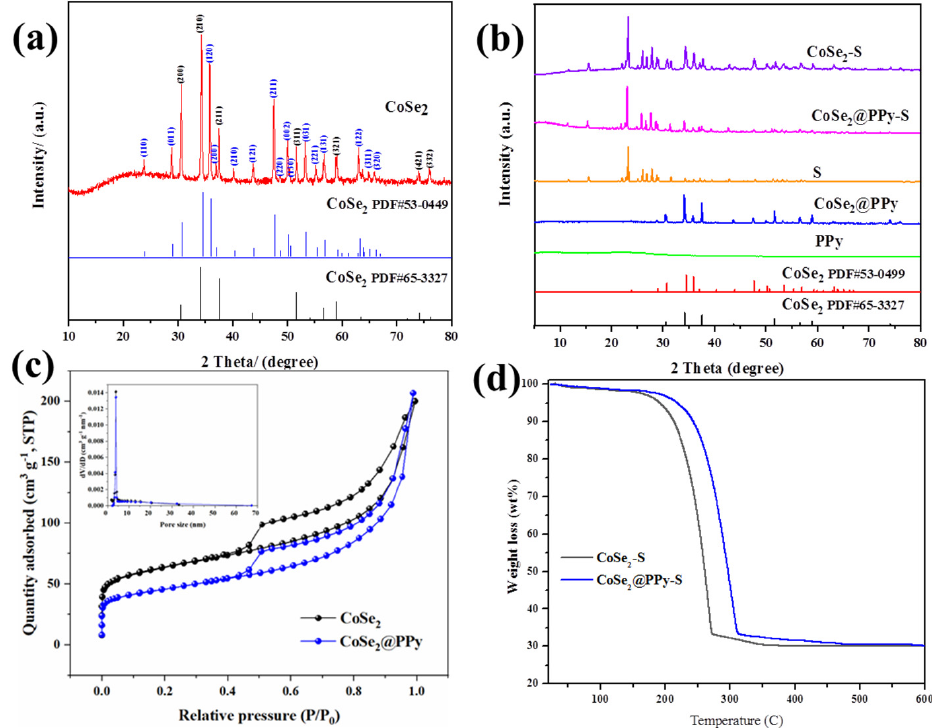
Figure 2. ( a ) XRD patterns of CoSe 2 composites. ( b ) XRD patterns of PPy, CoSe 2 @PPy, S, CoSe 2 @PPy-S, and CoSe 2 -S composites. ( c ) The N 2 adsorption/desorption curves of CoSe 2 and CoSe 2 @PPy composites. The illustration is the aperture distribution of CoSe 2 and CoSe 2 @PPy composites. ( d ) TGA curve of CoSe 2 @PPy-S composites.